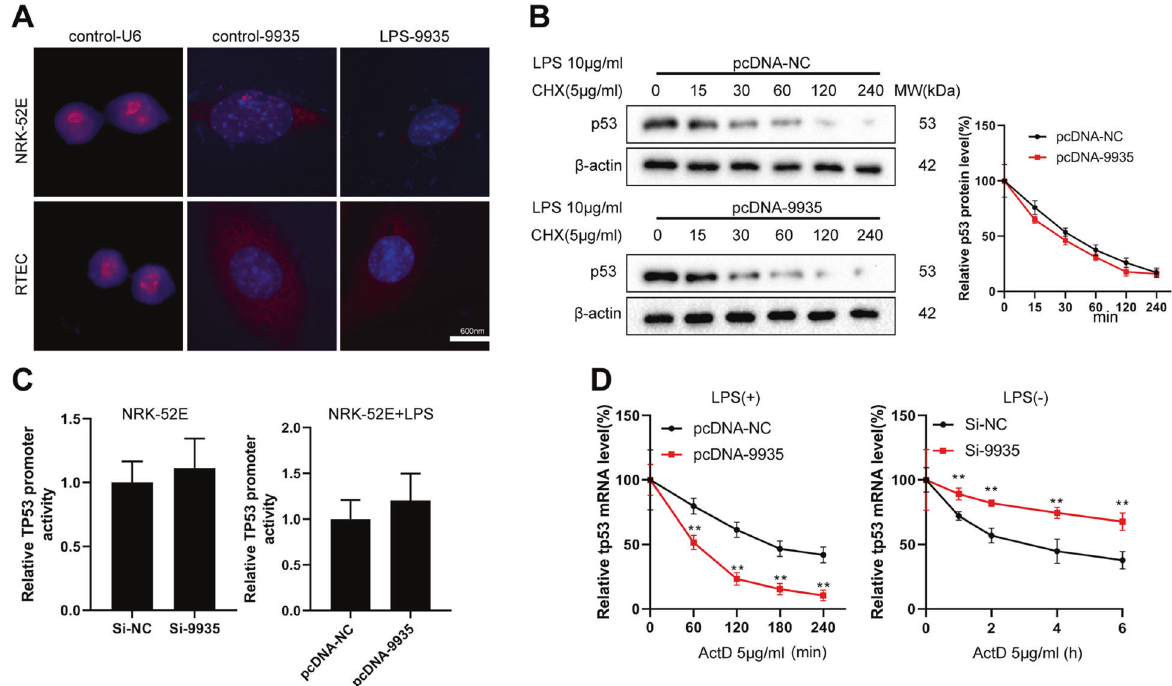
Fig. 4 LncRNA 9935 regulated the stability of Tp53 . A Fluorescence in situ hybridization (FISH) was executed to con fi rm the location of 9935 (red) in NRK-52E cells and rat primary RTECs. Nuclei were stained blue with DAPI. B NRK-52E cells were transfected with pcDNA-NC or pcDNA- 9935 and then treated with LPS and cycloheximide (CHX; 5 μ g/ml). The protein level of p53 was measured at the indicated time points after CHX administration. C , D NRK-52E cells were divided into four groups: si-NC, si-9935, pcDNA-NC + LPS, and pcDNA-9935 + LPS. C The promoter activity of Tp53 was detected by luciferase gene reporter assay. D Each group of cells was treated with actinomycin D (AtcD; 5 μ g/ml) and the Tp53 mRNA level was determined by qRT-PCR at the indicated time points. ** P < 0.01 vs. pcDNA-NC or